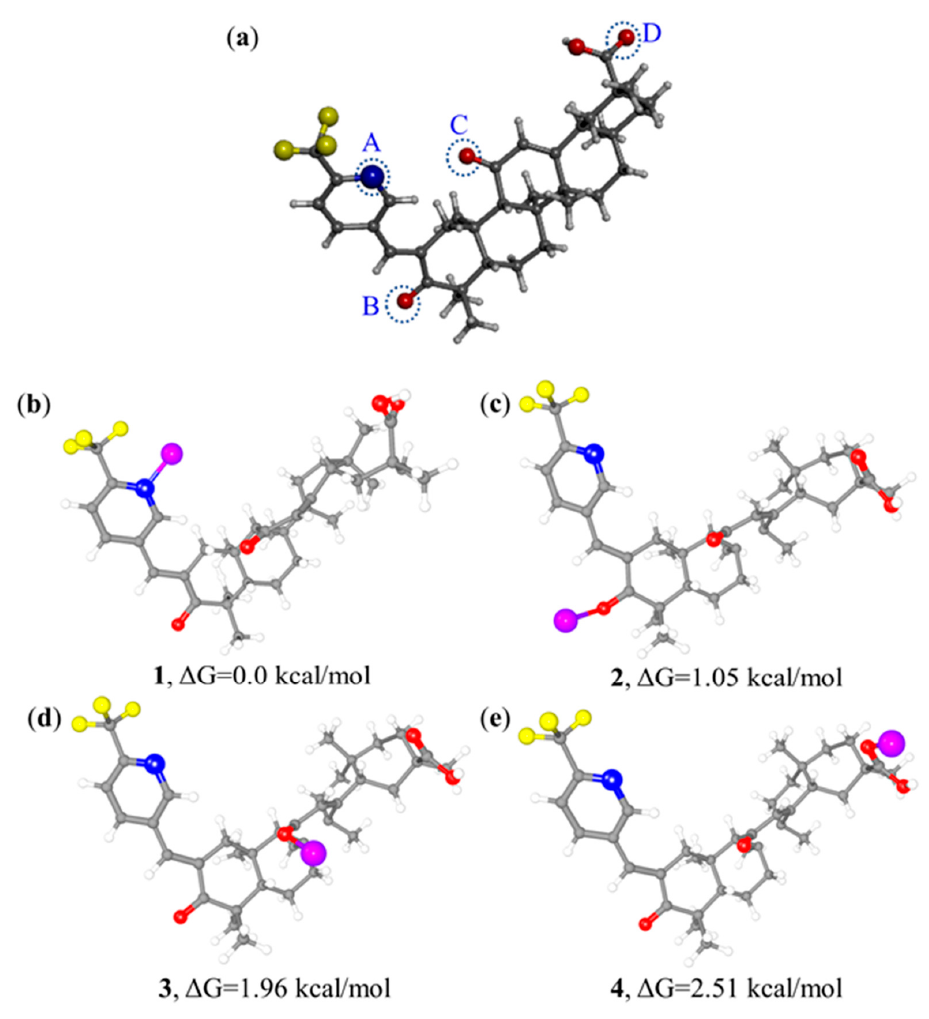
Figure 3. ( a ) Crystal structure of GA-O-09 with four potential binding sites: A, B, C and D. ( b – e ) Optimized structures of [GA-O-09·Cu 2+ ] complexes with copper ion binding at the potential sites, respectively, and corresponding Gibbs free energy values of the four optimized structures. Carbon atoms are presented in gray, hydrogen atoms in white, oxygen atoms in red, nitrogen atoms in blue, and copper atoms in purple.